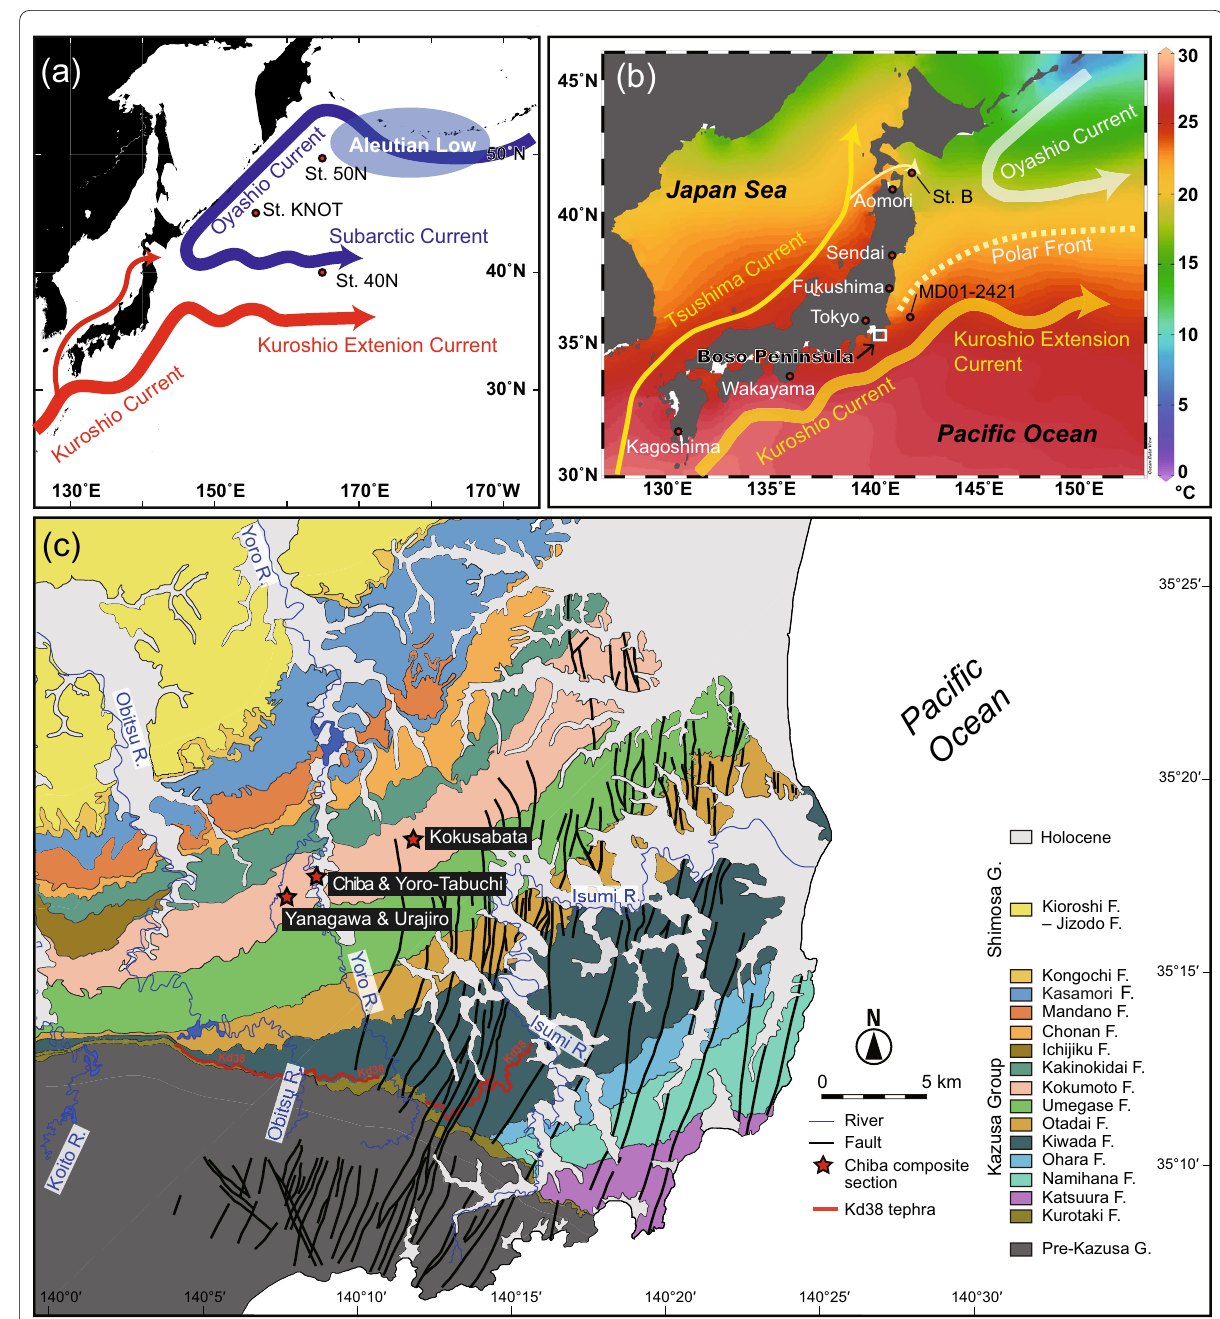
Fig. 1 Maps showing a major ocean currents around Japan, b summer sea-surface temperatures around the Boso Peninsula, and c simplified geological map (Kazaoka et al. 2015). Red stars in ( c ) indicate locations of the Urajiro, Yanagawa, Yoro River, Yoro-Tabuchi, and Kokusabata sections that comprise the Chiba composite section